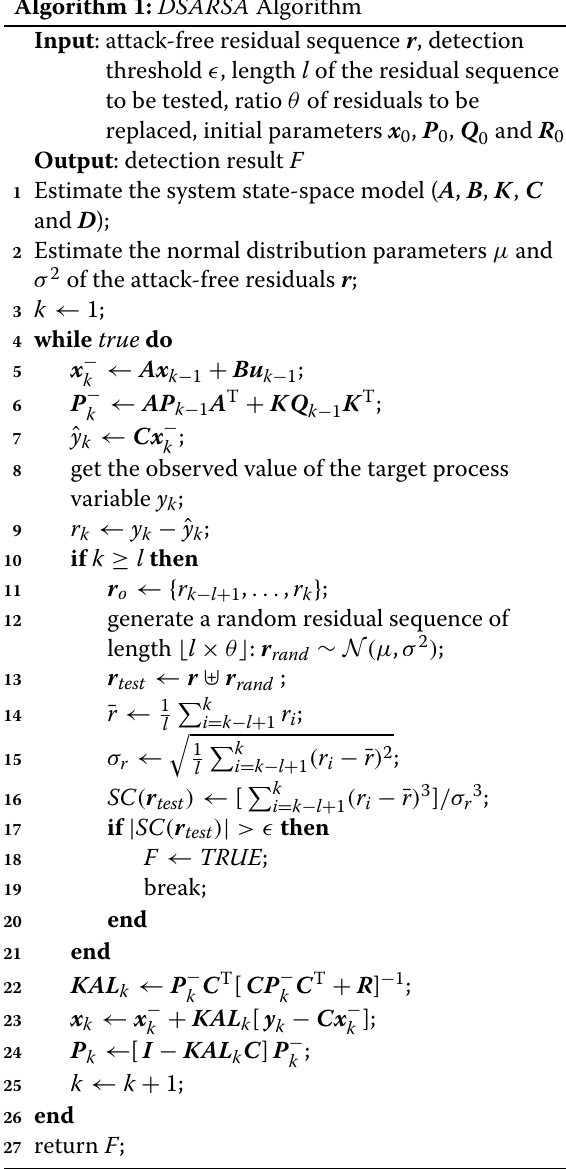
Algorithm 1: DSARSA Algorithm